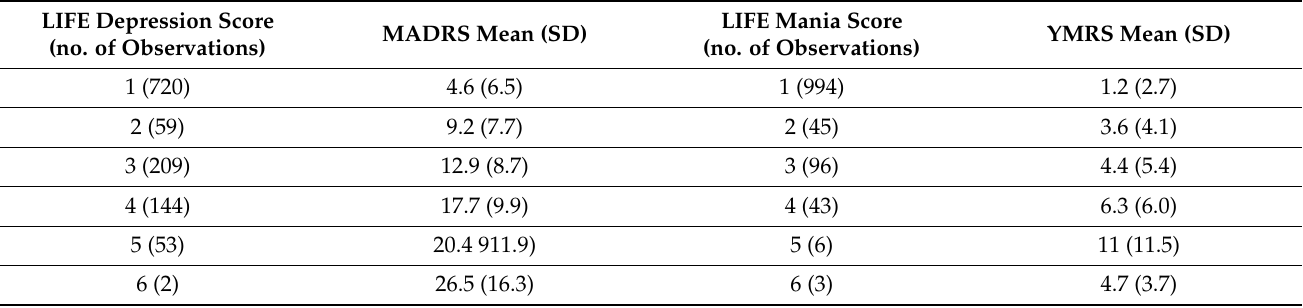
Table 2. Mean Mood Rating Scale Scores at Each Longitudinal Interval Follow-up Evaluation (LIFE) Score.